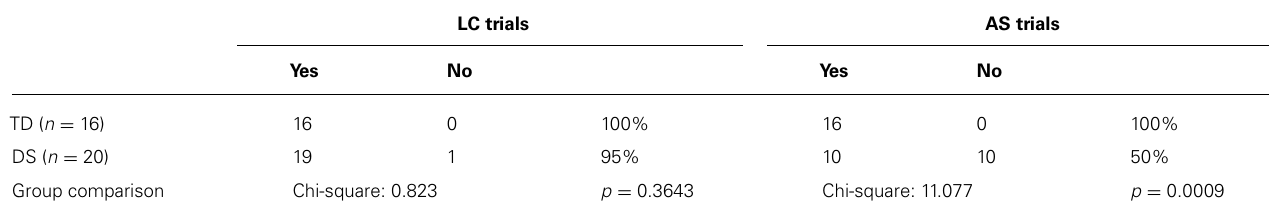
Table 2 | Numbers of participants who exhibited selectivity for the rewarded locations on either their first or their first three choices upon entering the arena, on LC andAS trials.